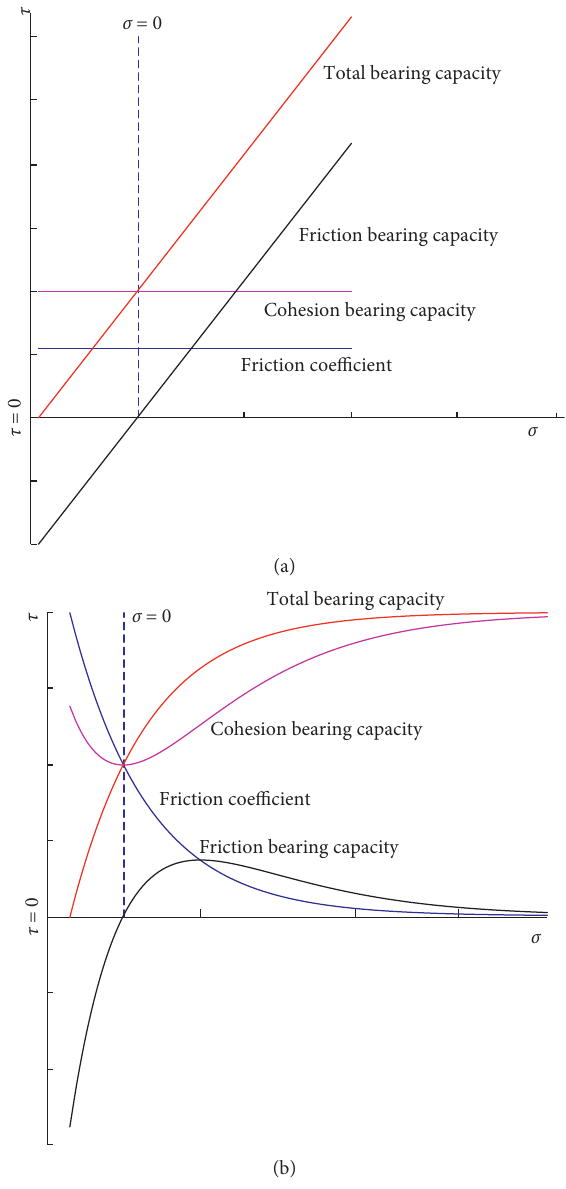
Figure 11: Evolution schematic diagram of rock bearing capacity composition. (a) Linear strength envelope. (b) Nonlinear strength